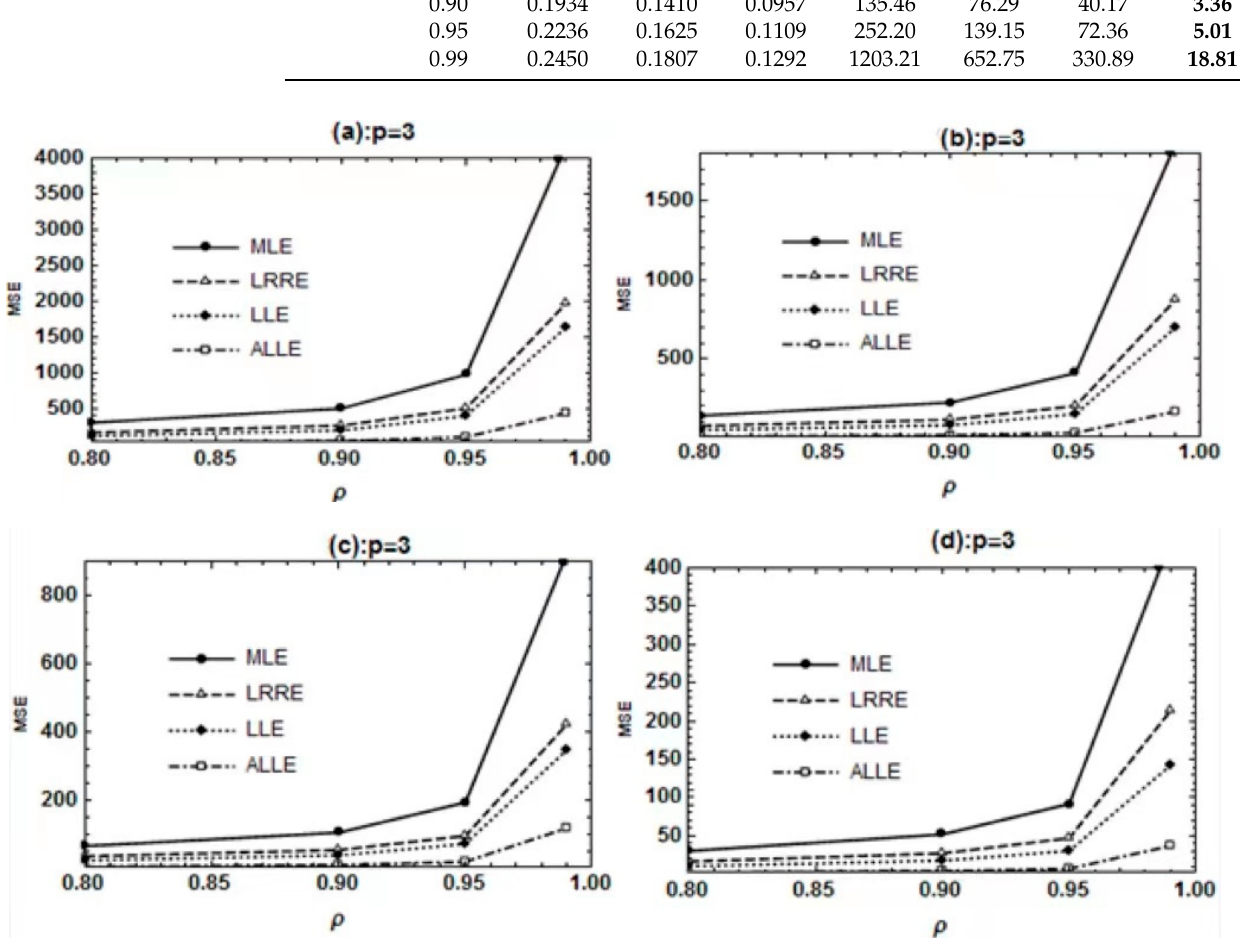
Figure 1. The BLRM estimators in relation to multicollinearity: ( a ). 𝑛 = 50 , ( b ). 𝑛 = 100 , ( c ). 𝑛 = 200 , ( d ). 𝑛 = 400 .